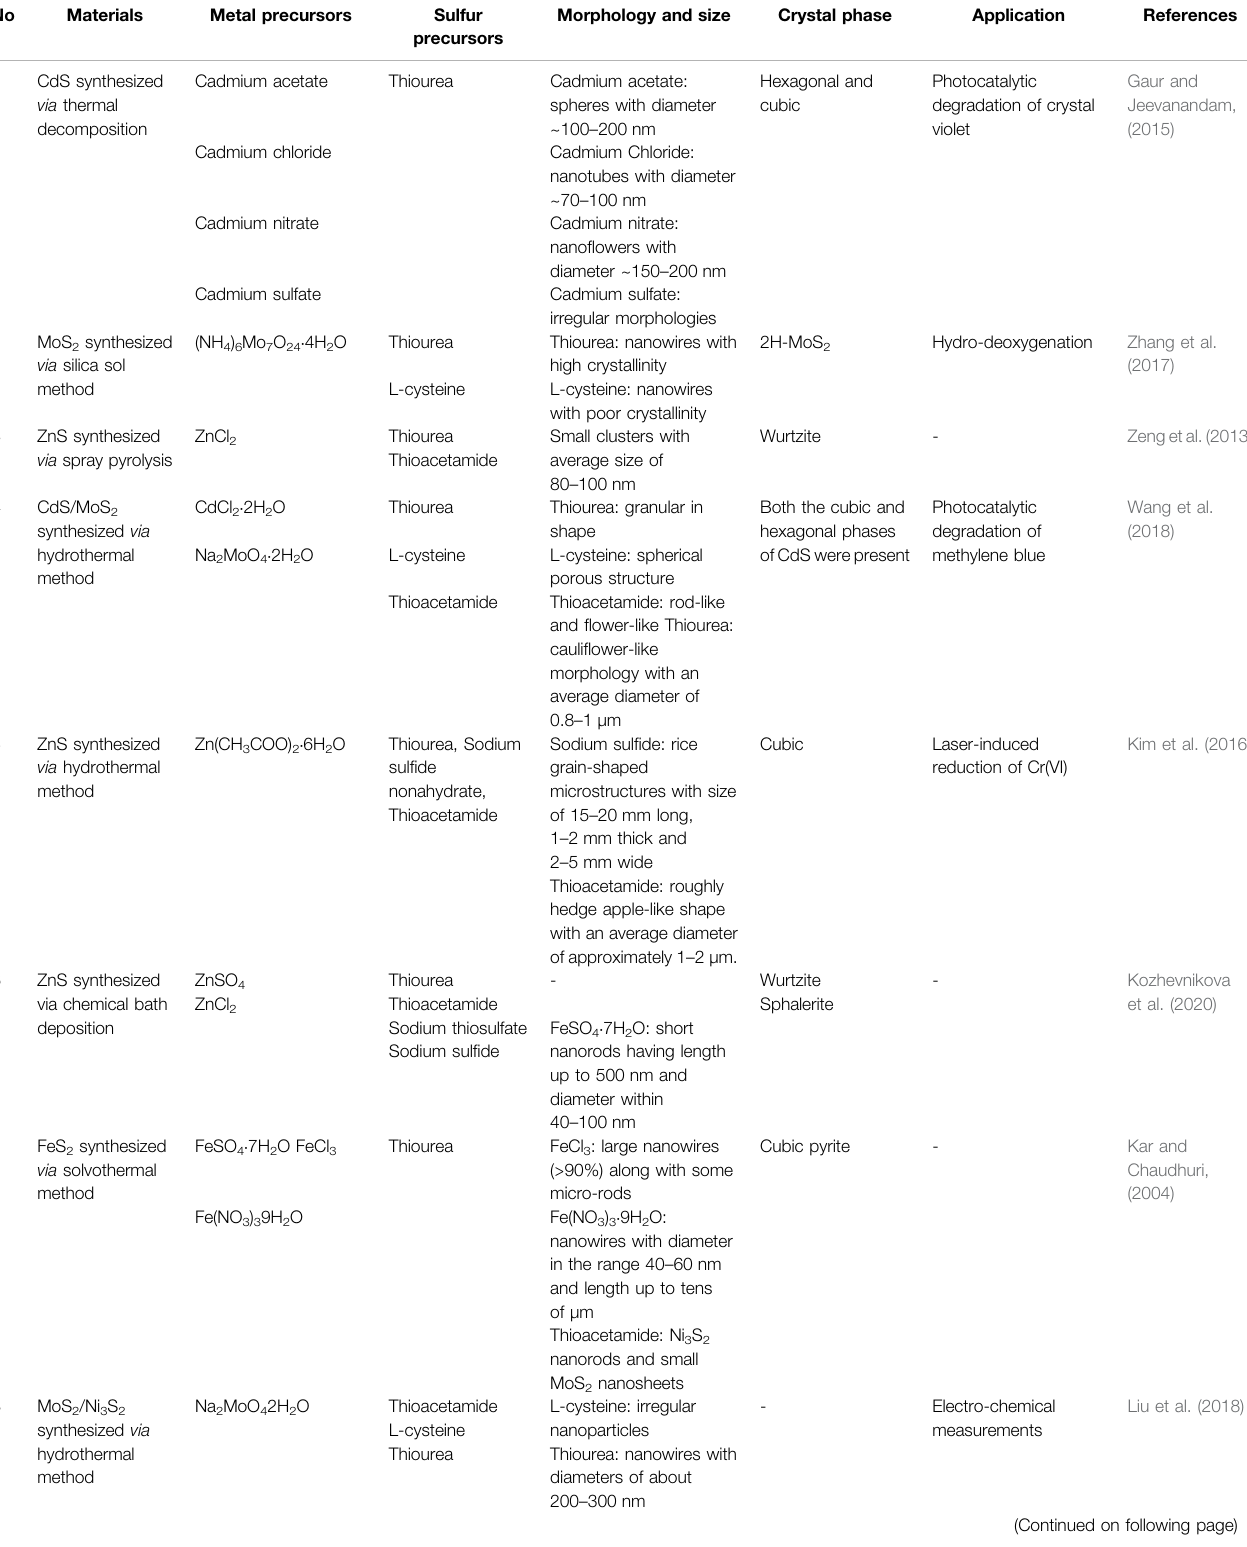
TABLE 2 | Summary of previous work on the effect of anions on the morphology, particle size, and crystal structure of various